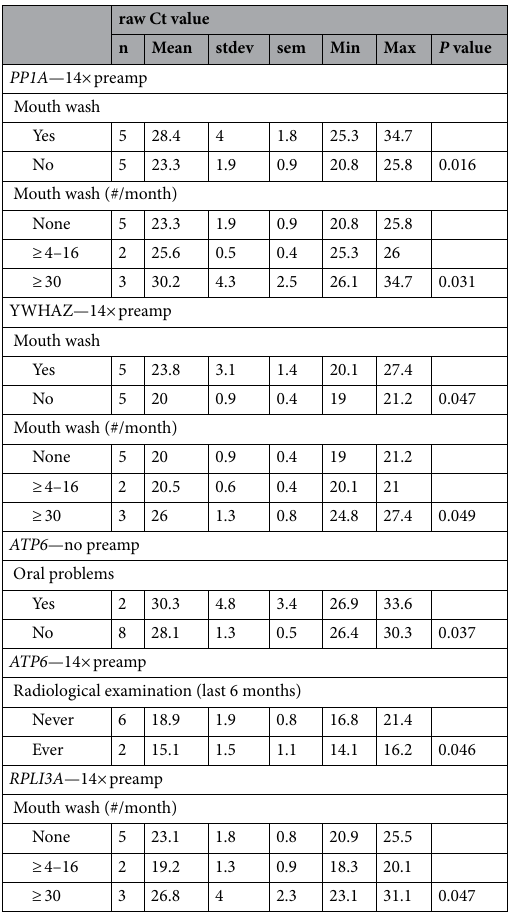
Table 2. Overview of the housekeeping gene expression results (raw Ct values either without pre-amplification or after 14× pre-amplification) and the significant correlations with sociodemographic and epidemiological characteristics. Provided are numbers (n) per category and corresponding descriptive statistics: mean, minimum [min], maximum [max], standard deviation [stdev] and standard error of the mean [sem]. Comparisons of categorical variables with gene expression values were performed using the non-parametrical Kruskal–Wallis (KW)